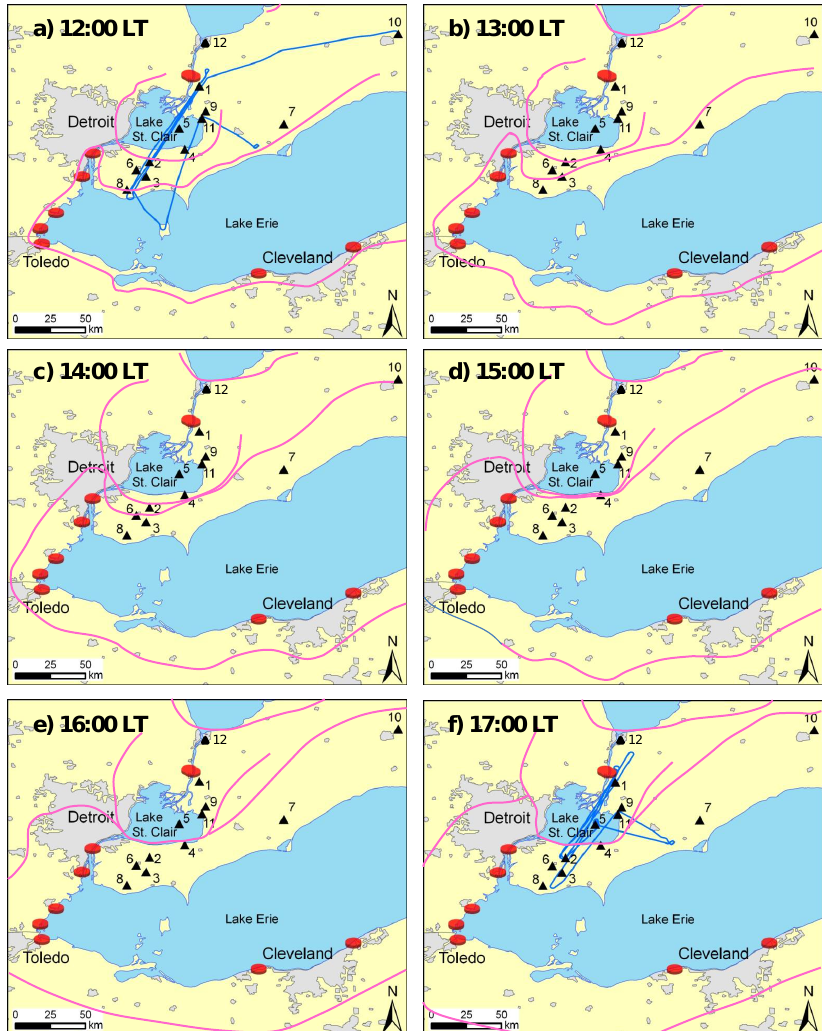
Fig. 1. Progression of lake-breeze fronts from 12:00–17:00LT on 25 June. Position of lake-breeze fronts shown in magenta lines. Tracks for Flights 4 and 5 are shown as blue lines in (a) and (f) respectively. SO 2 major point sources shown as red circles (SO 2 > 10000 tons/year). Surface sites in black triangles: (1) Sombra, (2) Woodslee, (3) Cottam, (4) Lighthouse Cove, (5) LSC buoy, (6) Essex, (7) Ridgetown, (8) Harrow, (9) Bear Creek, (10) London, (11) Mitchell’s Bay, (12)